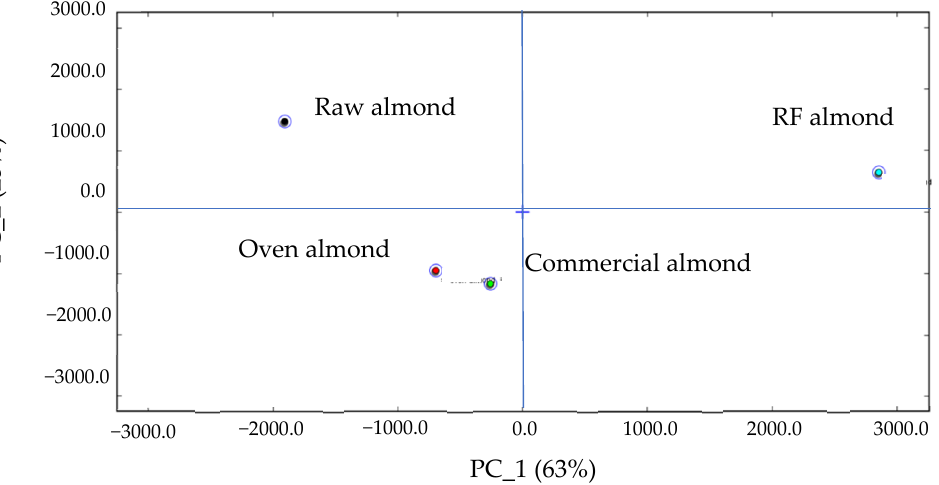
Figure 9. Principal component analysis of raw, RF-roasted, oven-roasted, and commercial almonds.